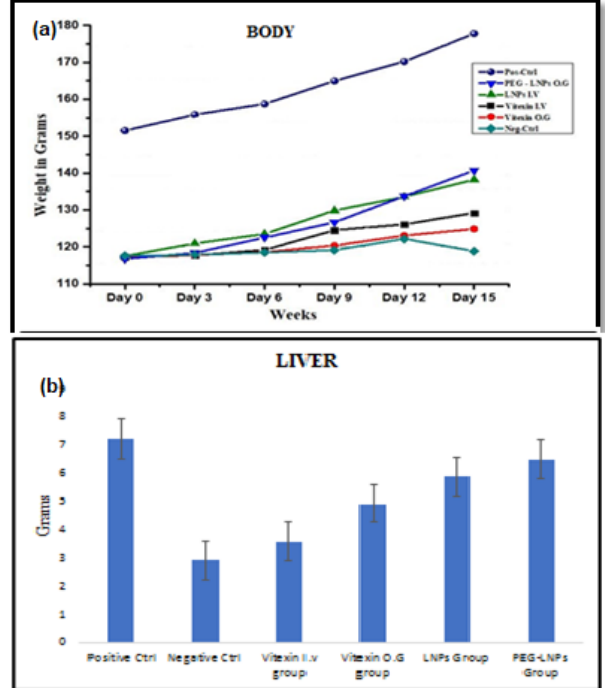
Figure 9. Weight Analysis of control and treatment groups ( a ) Body ( b ) Liver .